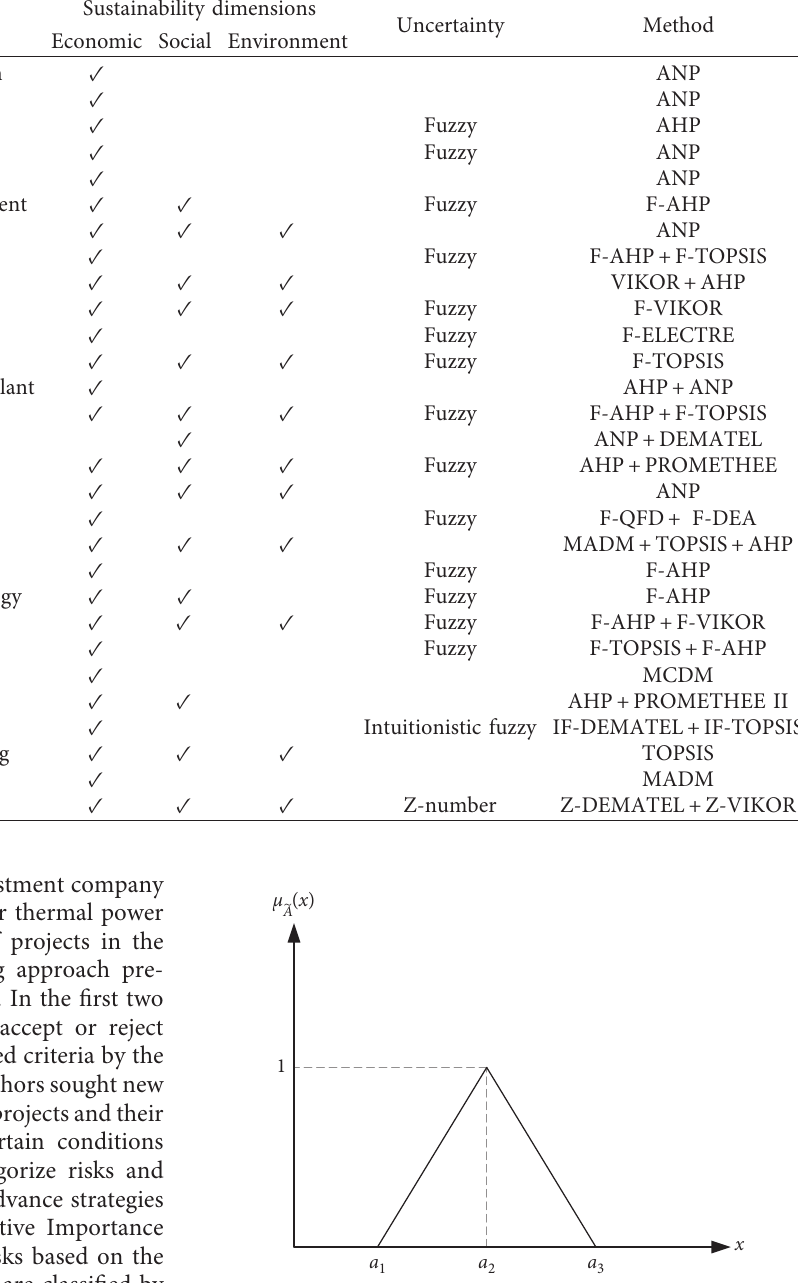
Figure 1: Triangular fuzzy